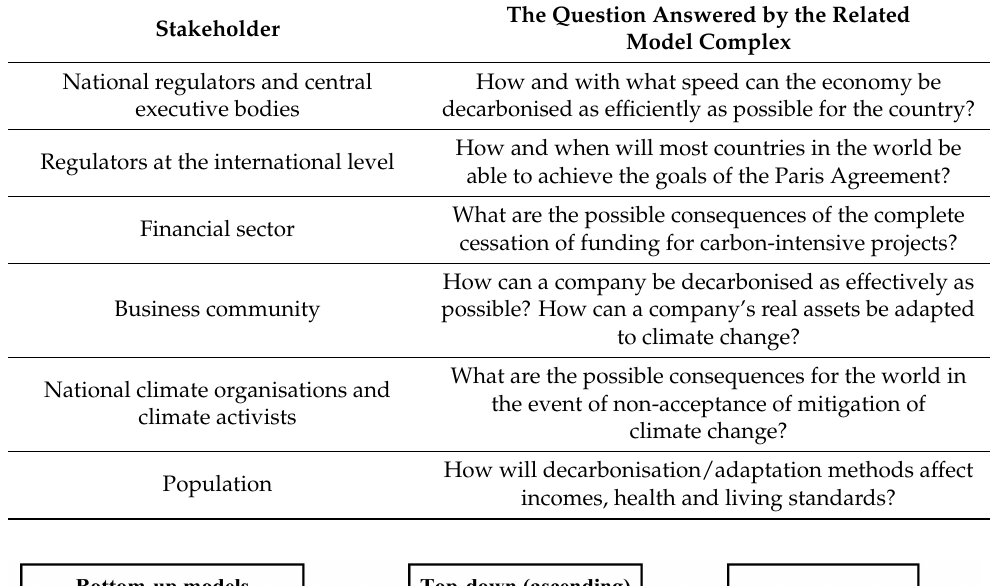
Table 3. The main stakeholders of the decarbonisation process. Adapted with permission from [31]. Copyright 2018, United Nation.